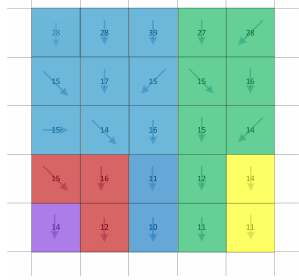
Figure 3: Upstream catchment area of grid cells